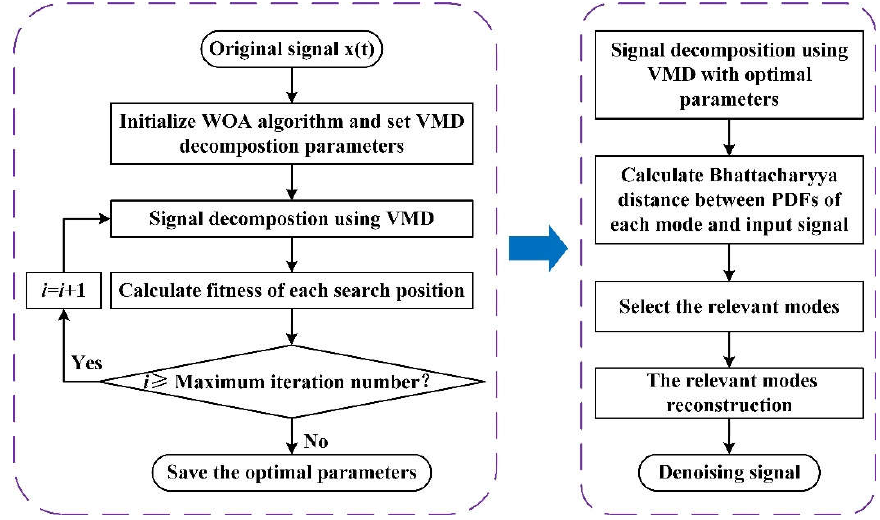
Figure 1. Flowchart of the proposed variational mode decomposition (VMD)-whale optimization algorithm (WOA). PDF is probability density function.